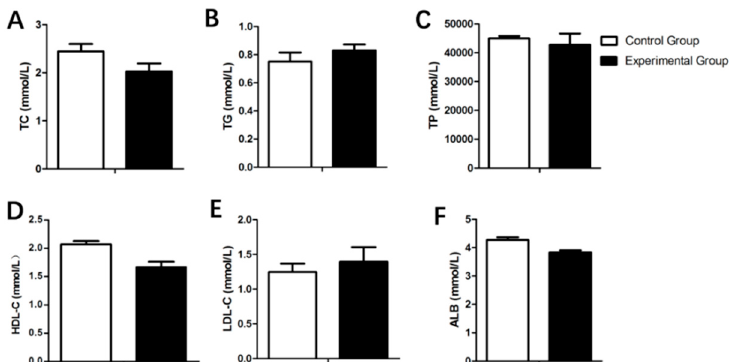
Figure 6. E ff ects of fasting caecotrophy on serum biochemical indices (( A ): total cholesterol (TC); Figure 6. Effects of fasting caecotrophy on serum biochemical indices ( A : total cholesterol (TC); B : ( B ): triglycerides (TG); ( C ): total protein (TP); ( D ): high-density lipoprotein cholesterol (HDL-C); triglycerides (TG); C : total protein (TP); D : high-density lipoprotein cholesterol (HDL-C); E : low- ( E ): low-density lipoprotein cholesterol (LDL-C); ( F ): albumin (ALB)) in rabbits. Values are presented as means ± SD.